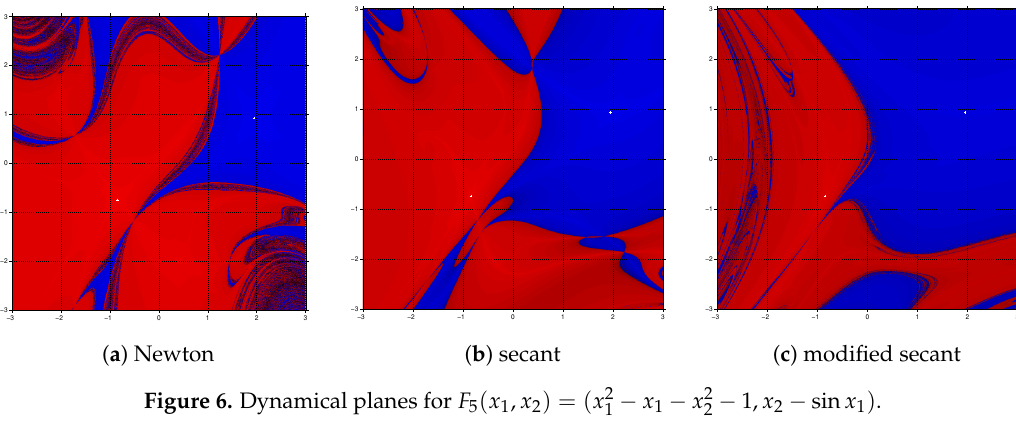
− x − x 2 − 1, x − sin x ) . 2 1 1 2 1